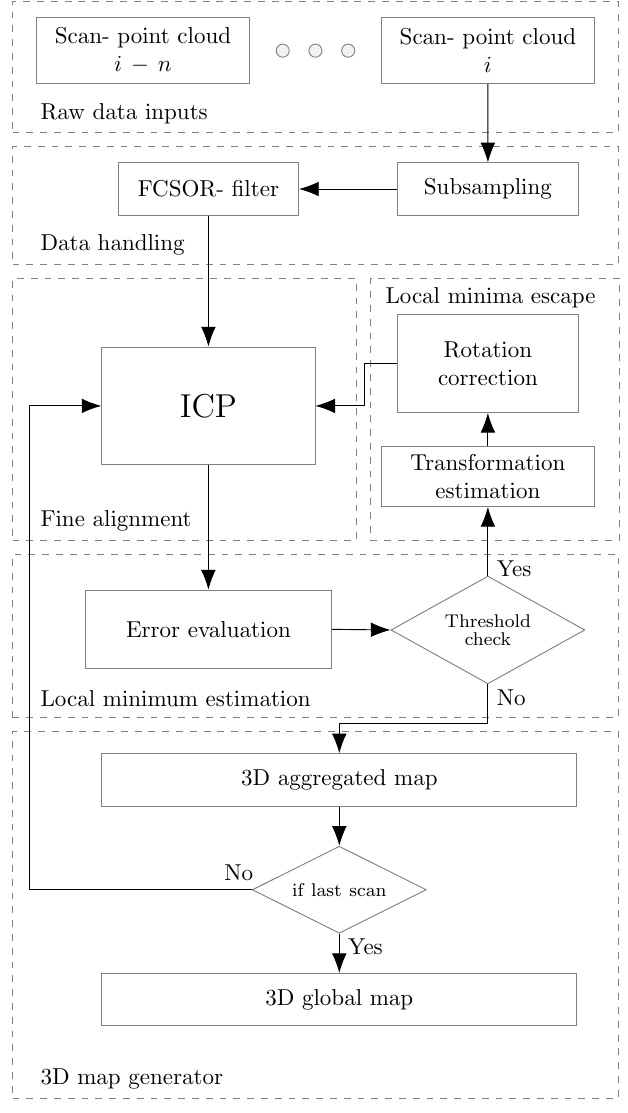
Figure 2. Novel 3D model registration framework